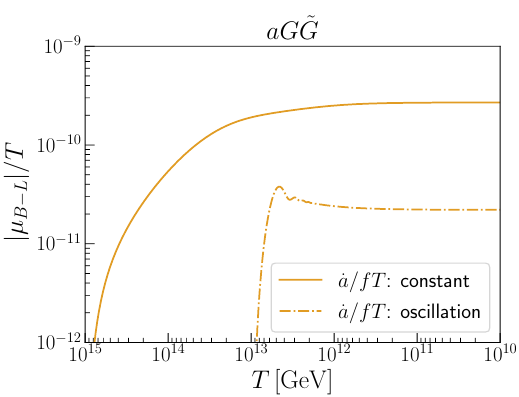
Figure 4 . The time evolution of the B L asymmetry produced from the shift-symmetric coupling (cid:0) ( a=f ) G ~ G for constant _ a= ( fT ) (solid) and oscillating _ a= ( fT )